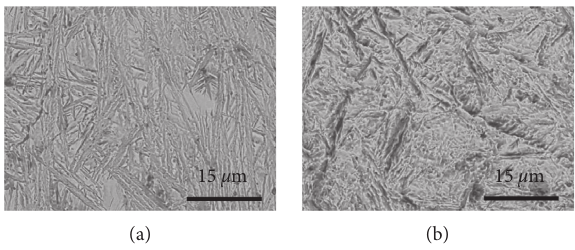
Figure 7: SEM images of the microstructure of the fusion zone: (a) AW and (b) AW-LSF.